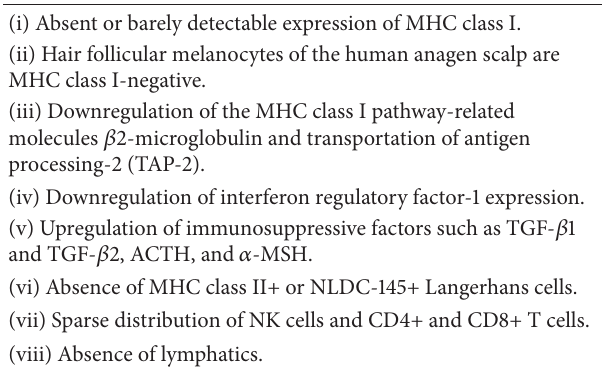
Table 1: The mechanism of HF immune